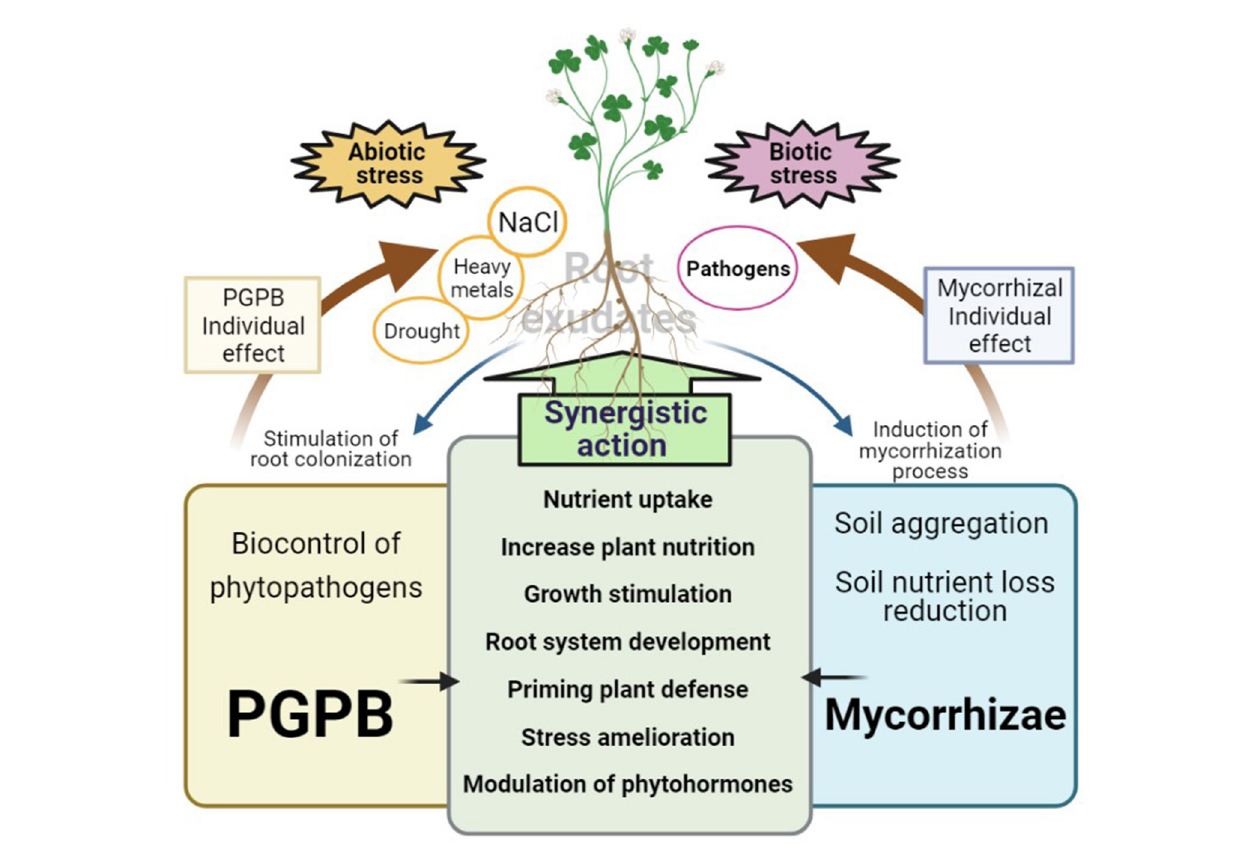
FIGURE 2 | Description of the individual and synergistic mechanisms exerted by mycorrhizae and PGPB. Mycorrhizae and PGPB contain very few individual mechanisms to interact with their plant host. For example, PGPB are mostly known as biocontrol agents of phytopathogens, while mycorrhizae have excellent activities to improve diverse soil properties; however, most of these shared beneficial activities between mycorrhizae and PGPB may be acting synergically to stimulate plant growth (directly or indirectly) either in the absence or presence of abiotic and biotic stress. Plant root exudates also stimulate the colonization of PGPB, as well as the mycorrhization process, accelerating the tripartite interaction